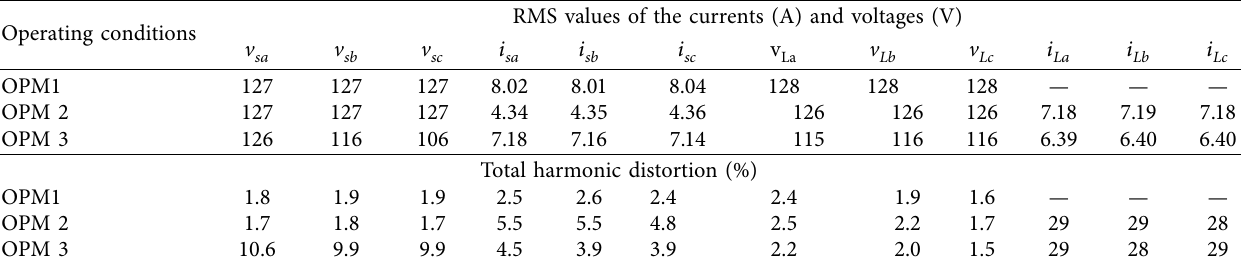
Table 2: Conditions assumed to regulate the flow of real power via the